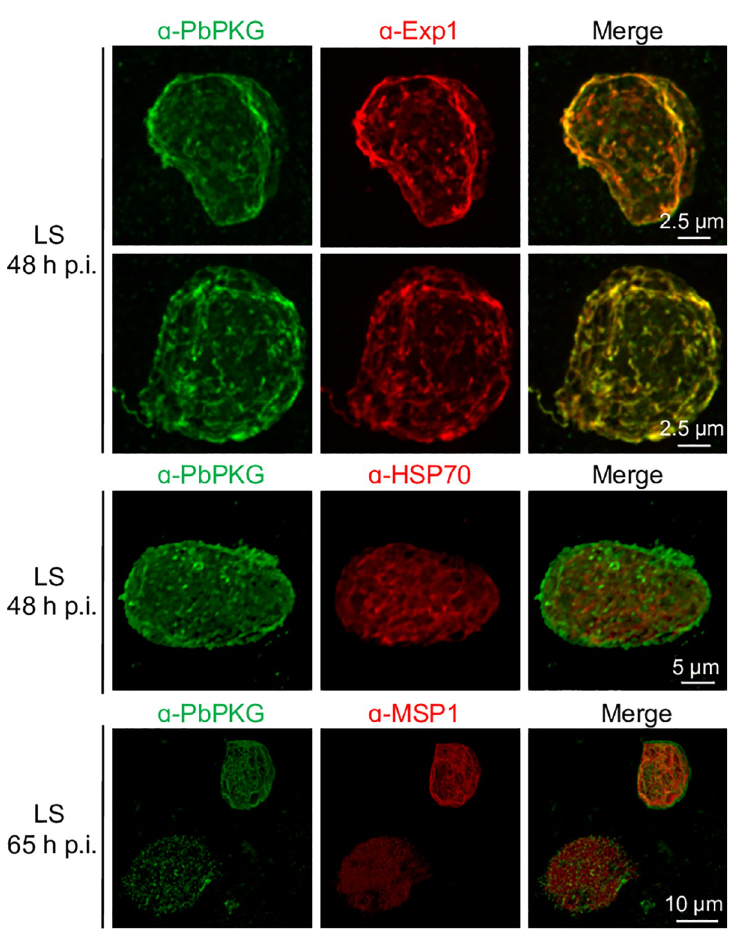
Fig 3. PbPKG localization liver stages. Representative images of PbPKG’s spatial expression in liver stages of P . berghei parasites expressing luciferase (PbLuc). Exp1 is a resident protein of the parasitophorous vacuole membrane, HSP70 is a cytoplasmic protein and Merozoite Surface Protein (MSP1) is a marker of the parasite plasma membrane.